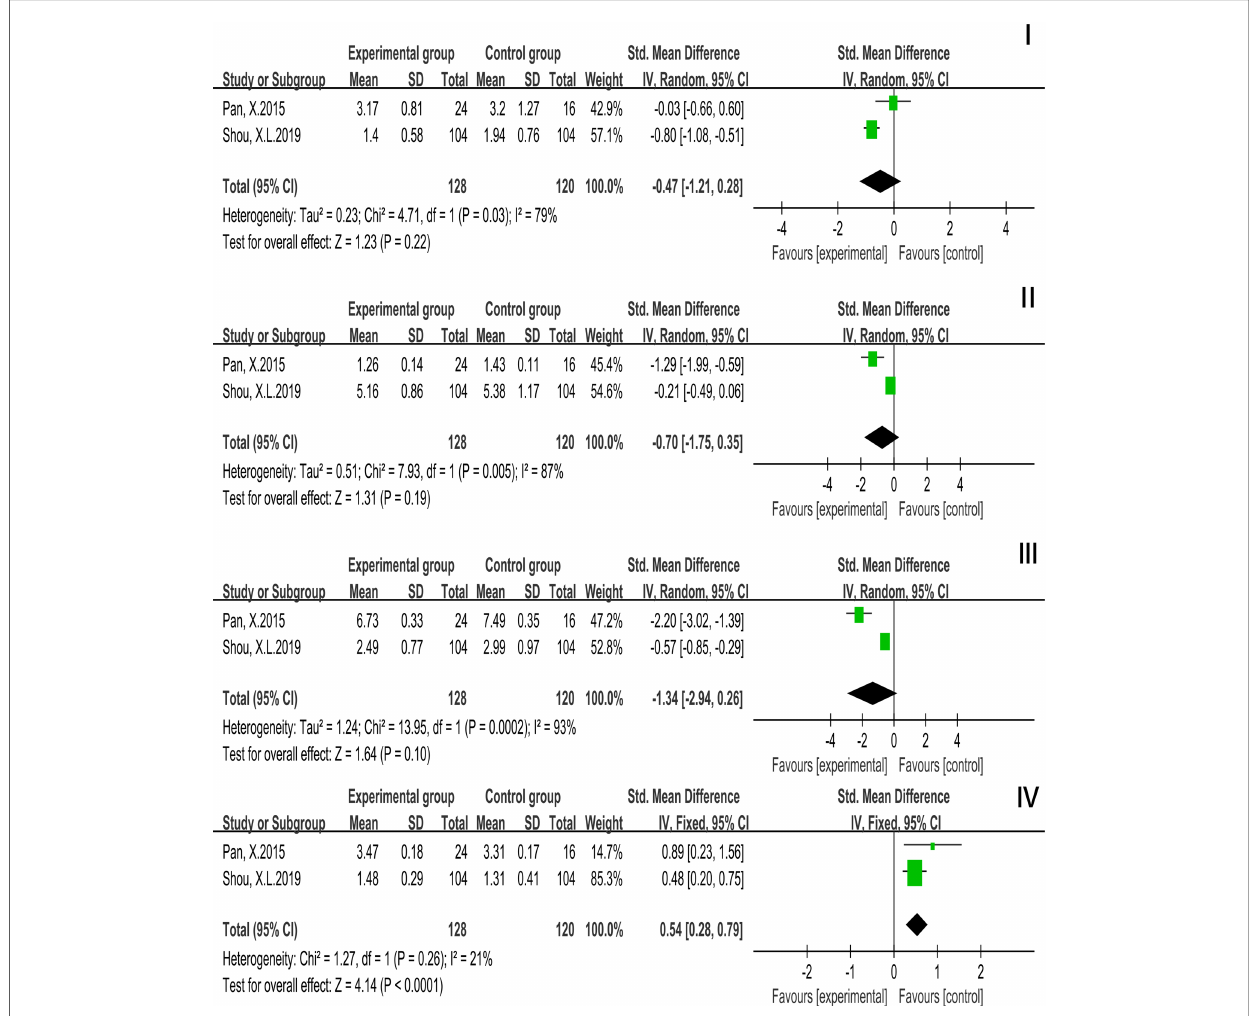
FIGURE 6 Forest plot of meta-analysis on the effect of Tai Chi exercise cycle on blood lipid related indexes (cycle <12 weeks). I, Total Cholesterol (TC); II, Triglyceride (TG); III, Low Density Lipoprotein (LDL-C); IV, High Density Lipoprotein